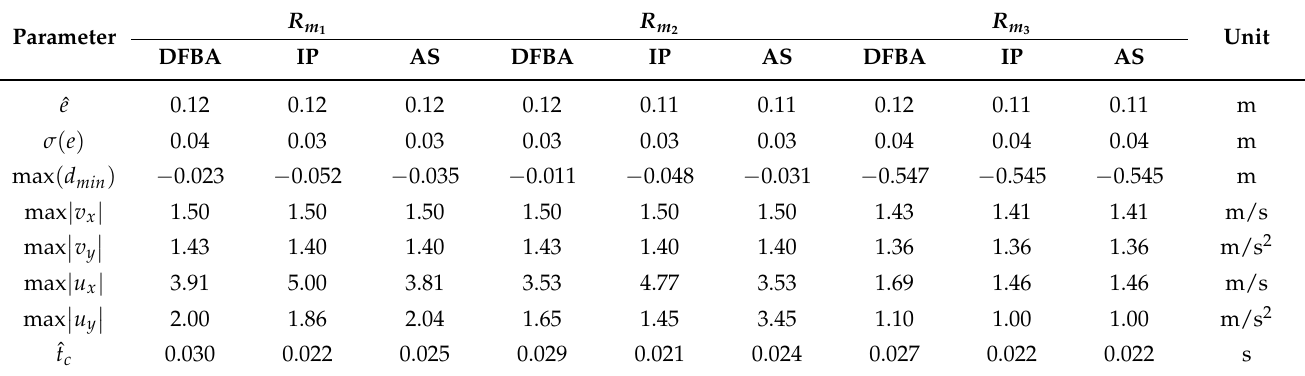
Table 4. Comparison of the results obtained using different optimisation